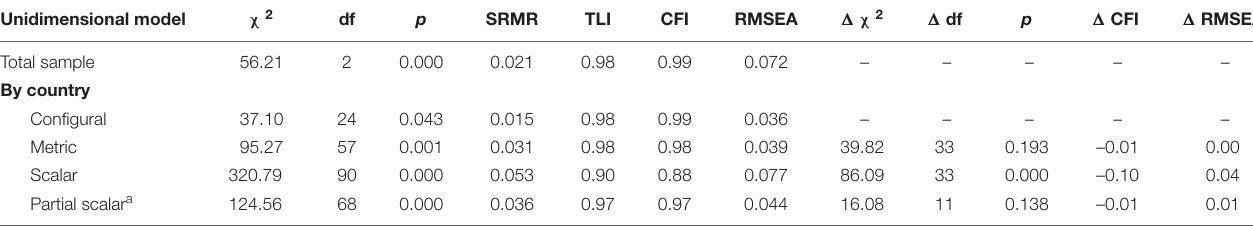
TABLE 5 | Unidimensional model fit indices and invariance models by country. Unidimensional model χ 2 df p SRMR